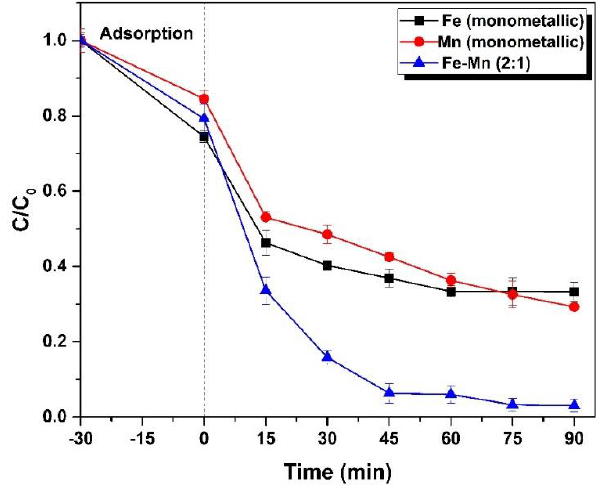
Figure 8. Comparison of bimetallic and mono metallic oxide catalysts for RhB removal.